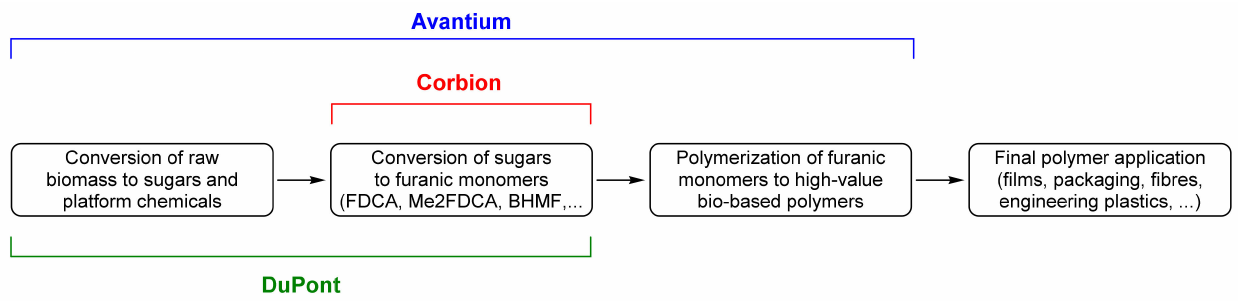
Figure 7. Furanic polymer supply chain sections covered by prominent production